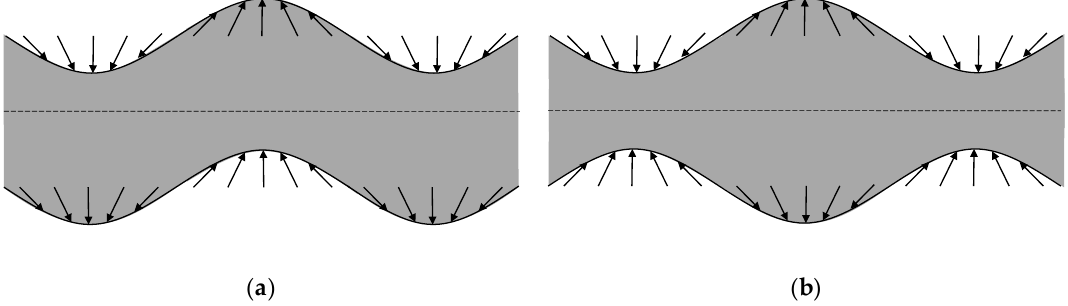
Figure 1. Particle displacement of ( a ) antisymmetric and ( b ) symmetric Lamb wave modes. The discontinuous line represents the middle of the plate.